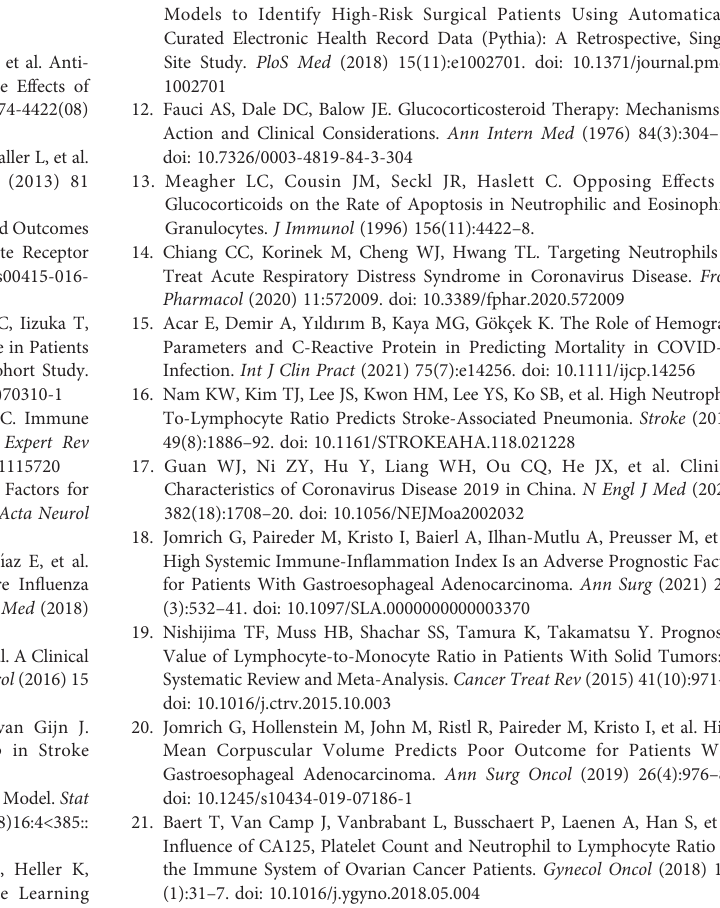
Supplementary Figure 1 | Neurologic outcome of the study population. The fi gure demonstrates percent distribution of Modi fi ed Rankin Scale (mRS) score pro fi les patients in both groups at (A) admission to the hospital and (B) discharge from the